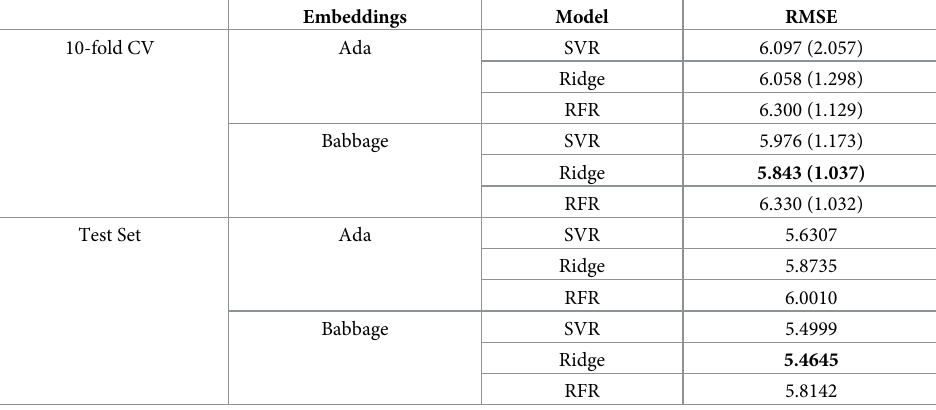
Table 7. MMSE prediction in terms of RMSE scores for three different models (SVR, Ridge and RFR) using text embeddings from GPT-3 (Ada and Babbage) on the 10-fold CV (top) with standard deviation and on the inference on test set (bottom). Bold indicates the best RMSE